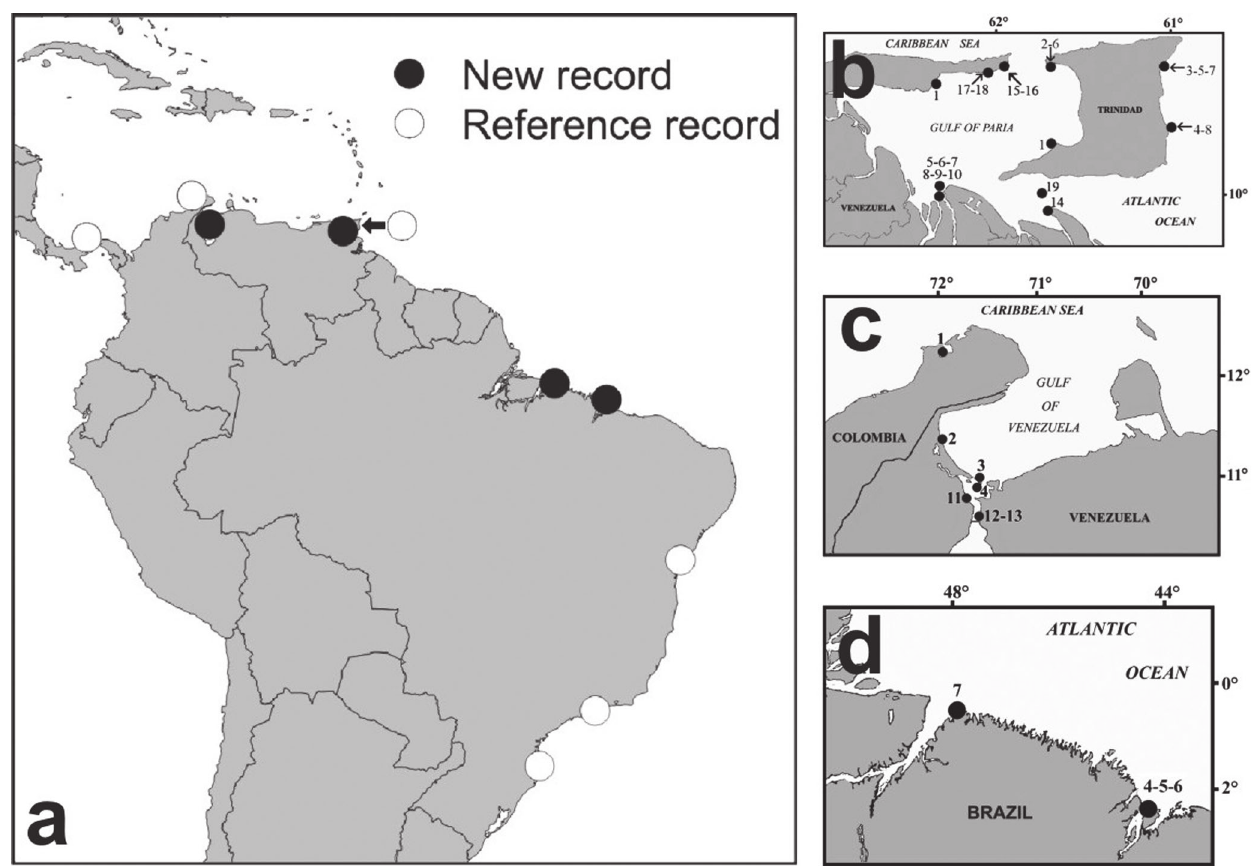
Fig. 2. Distribution of Omobranchus punctatus in Central and South American coasts. a ) Full circle represents new records and open circle represents records from literature; b ) Catch sites of Omobranchus punctatus in the eastern coast of Venezuela (Gulf of Paria) and Trinidad (see Table 1); c ) Localities with records of Omobranchus punctatus in western Venezuela (Gulf of Venezuela) and Colombia (Guajira Peninsula) (see Table 1) and d ) Localities with records of Omobranchus punctatus from Maranhão and Pará states, northern Brazil (see Table